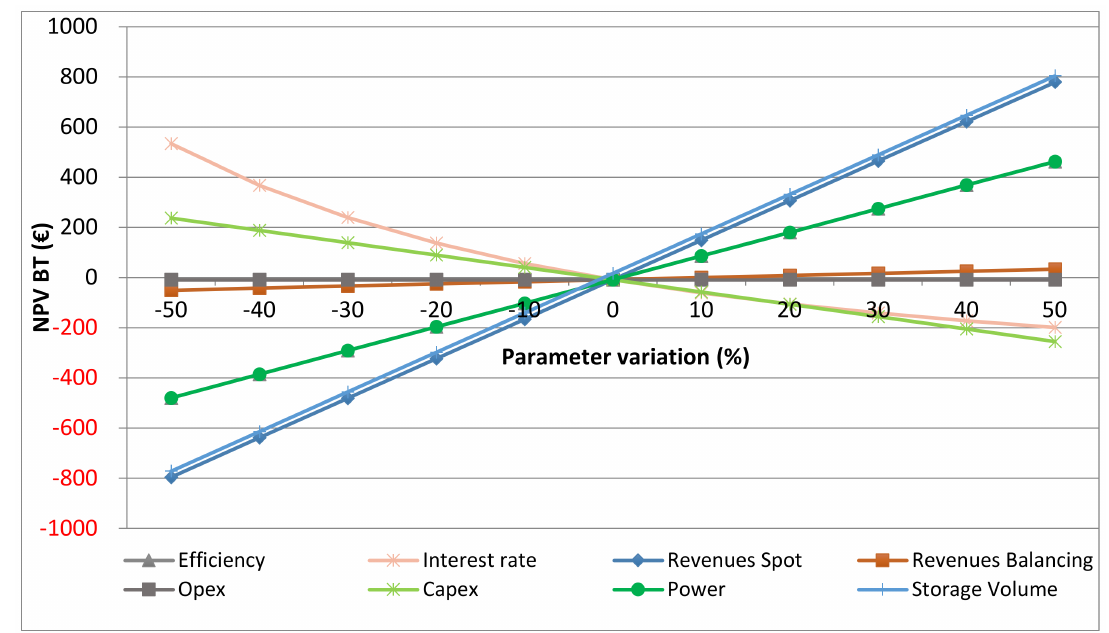
Figure 14. Sensitivity analysis of Scen. 2 on the net present value before tax, with a variation of ± 50% of key parameter